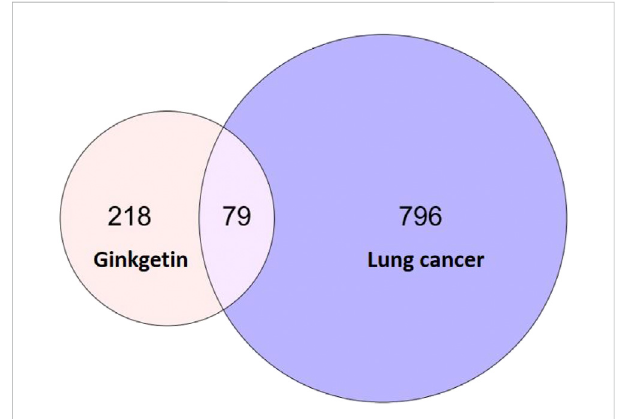
FIGURE 3 Venn diagram of a common target for lung cancer and GK.